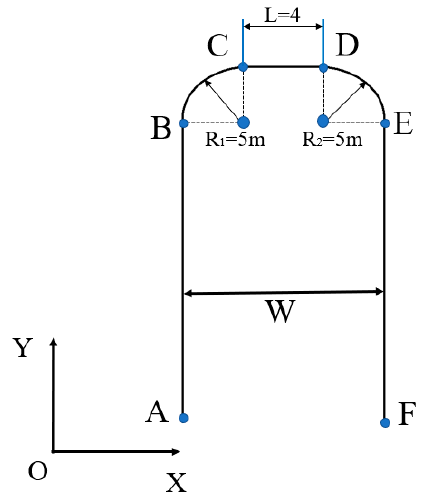
Figure 12. Working Figure 12. Working path.